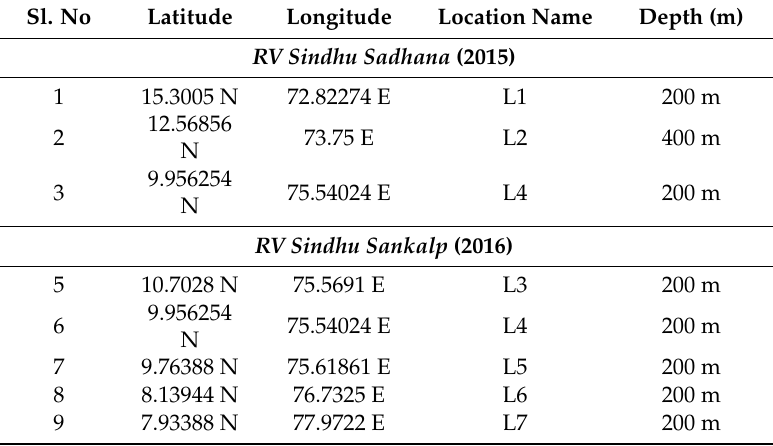
Table 1. Table showing the positions of the stations sampled during this study. Three stations were sampled during 2015 and five stations were sampled during 2016. Station L4 was sampled during both years. Sl. No Latitude Longitude Location Name Depth